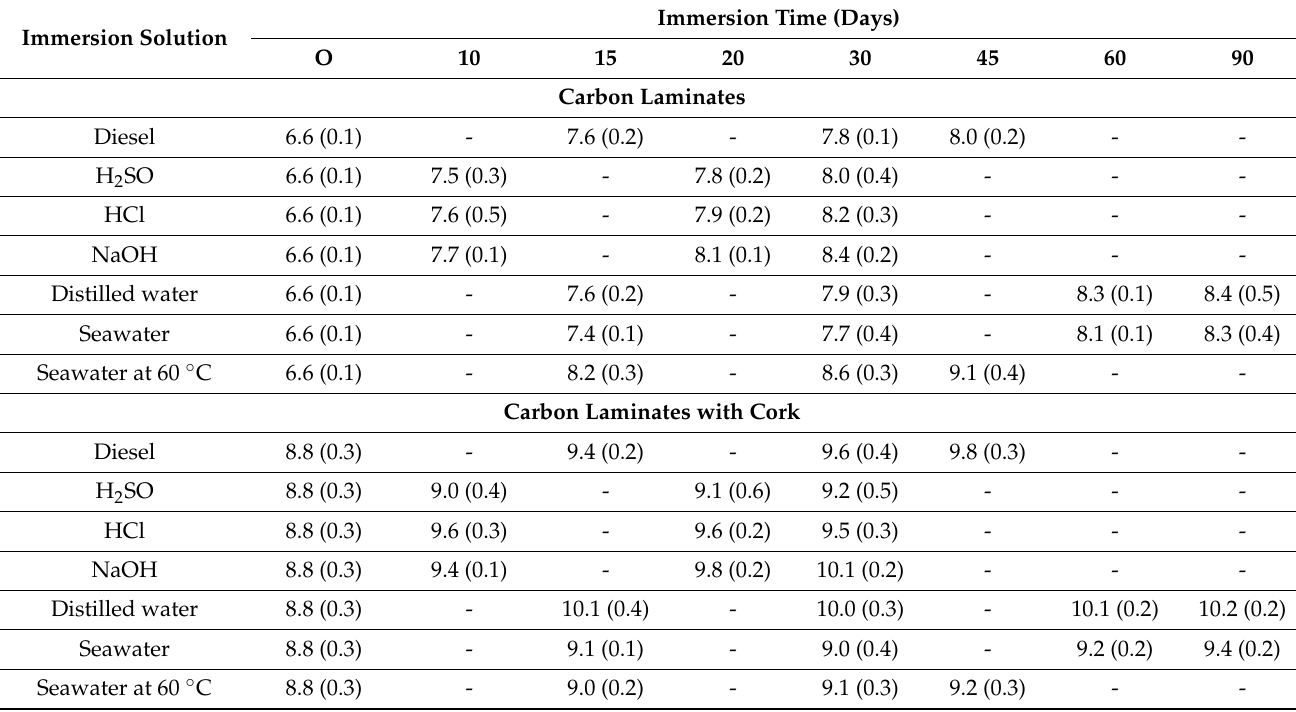
Table 5. Maximum displacement obtained for different harsh solutions and immersion time (values in mm).